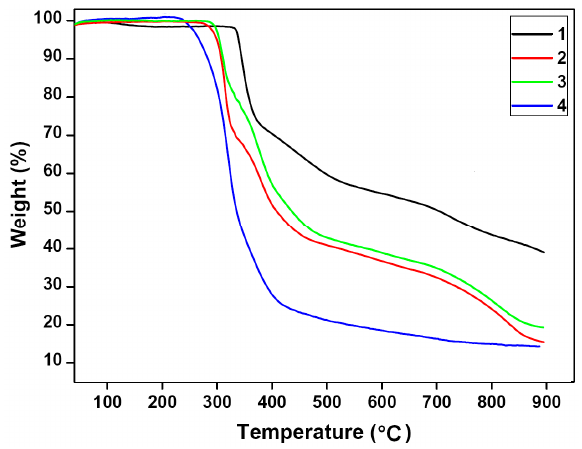
Figure 6. The thermogravimetric analyses (TGA) curves for 1 – 4 .